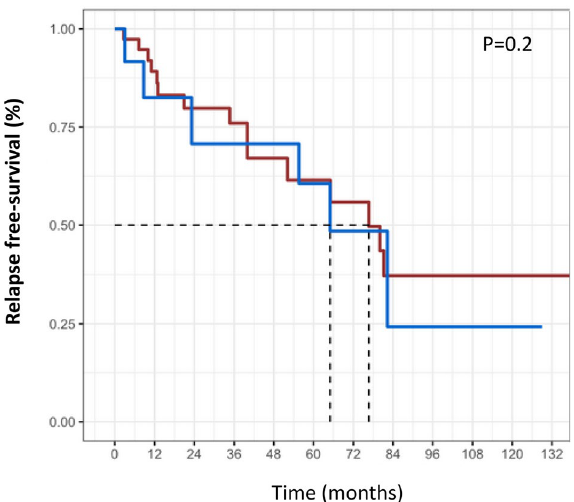
Figure 2. Relapse free-survival with (red) and without (blue)